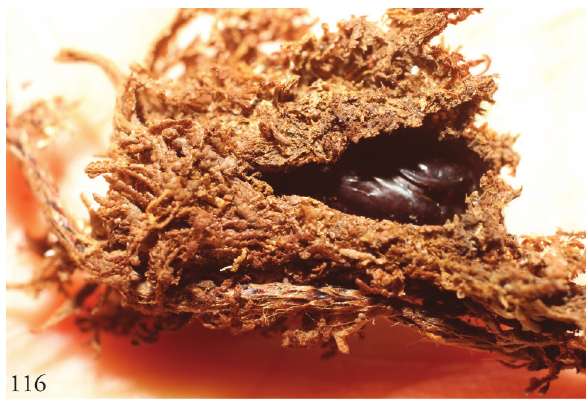
Figure 116. Cocoon of Lophmyra tacita